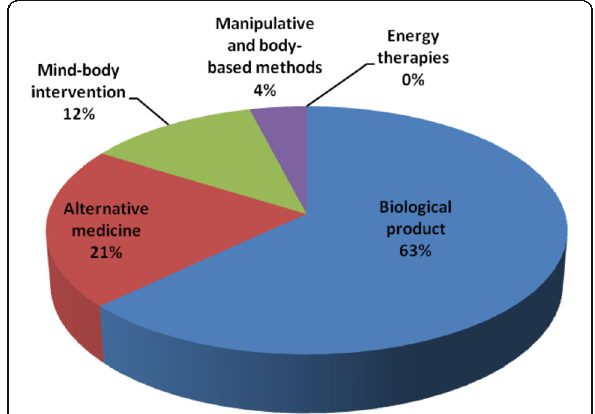
Fig. 2 Pattern of categories of CAM utilization among the respondents